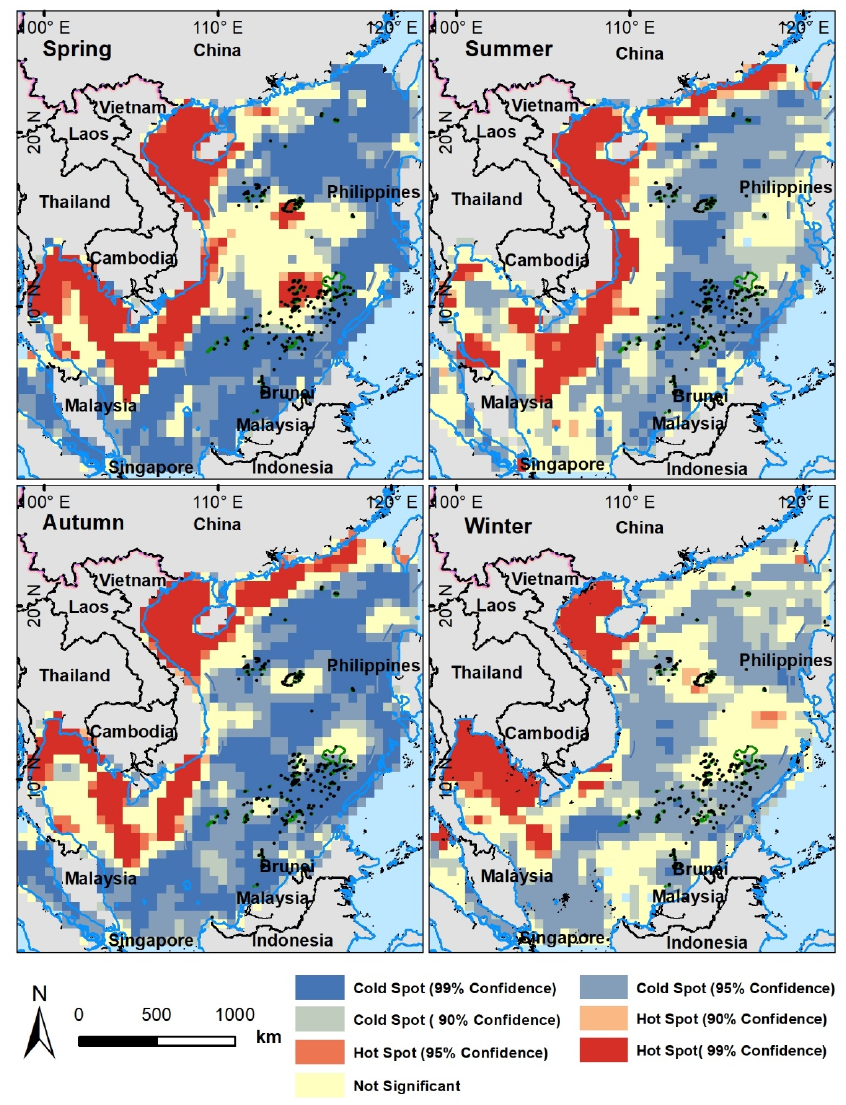
Figure 8. Spatial Getis-Ord Statistical Analysis results during 2012–2019 at the 0.5° grid level. Meanwhile, trajectories of cold spots in pelagic regions were characterized by three stages accompanied by seasonal contraction or expansion in spatial extent. First, cold spots shifted from marginal regions to inner regions with the extent contracted by 8.7%. Second, it expanded towards the surrounding regions with a peak in autumn and the ex- tent increased by 14.5%. Further, the cold spots sharply shrank to the marginal region with the extent contracted by 16.3% and minimum in winter. However, an inverse trend was evident for random spots in pelagic region in both spatial extent and distribution, and the spatial extent of random spots reached its peak and trough in winter and autumn, respec- tively. Accordingly, fishing activity trajectories were categorized into three cases sup- ported by Getis-Ord Gi* statistical analysis and seasonal analysis. The first one remained overall stable across the whole period with a slight contraction in certain times such as